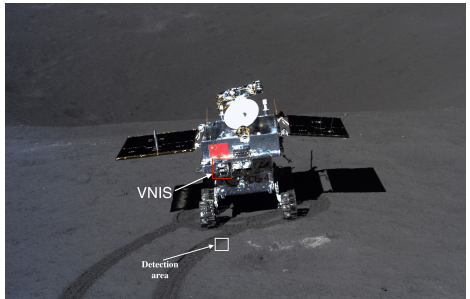
Figure 2. Image of Yutu-2 rover at exploration site A. Visible and near-infrared imaging spectrometer (VNIS) mounted at the front of the rover, marked by the red rectangle in the picture. The VNIS detection area was marked by the white rectangle, which is approximately 1 m below the spectrometer, and less than 5 m from the center of the rover. This figure was obtained from the CE-4 Terrain Camera (TCAM)